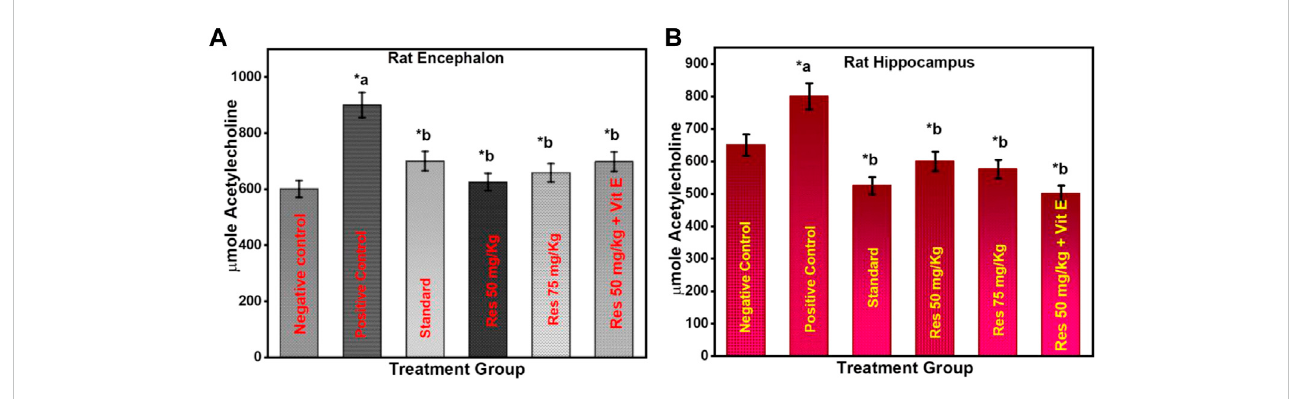
FIGURE 4 Effect of treatment on AChE activity in the animals (A) encephalon; (B) hippocampus. a negative control vs. positive control; b positive control vs. treatment